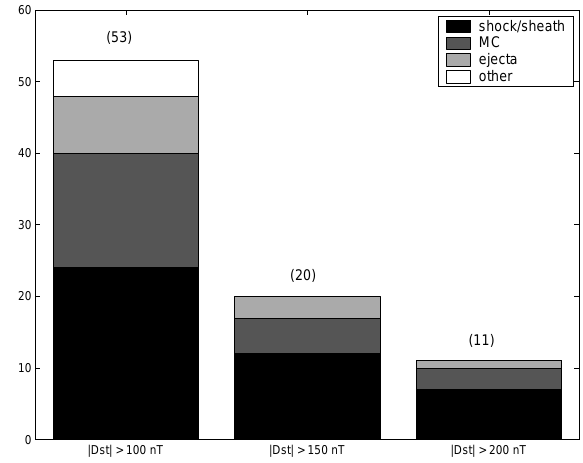
Fig. 1. Bars show the drivers of magnetic storms for three different level of the D st depression. The numbers above each bar present the total number of storms in that